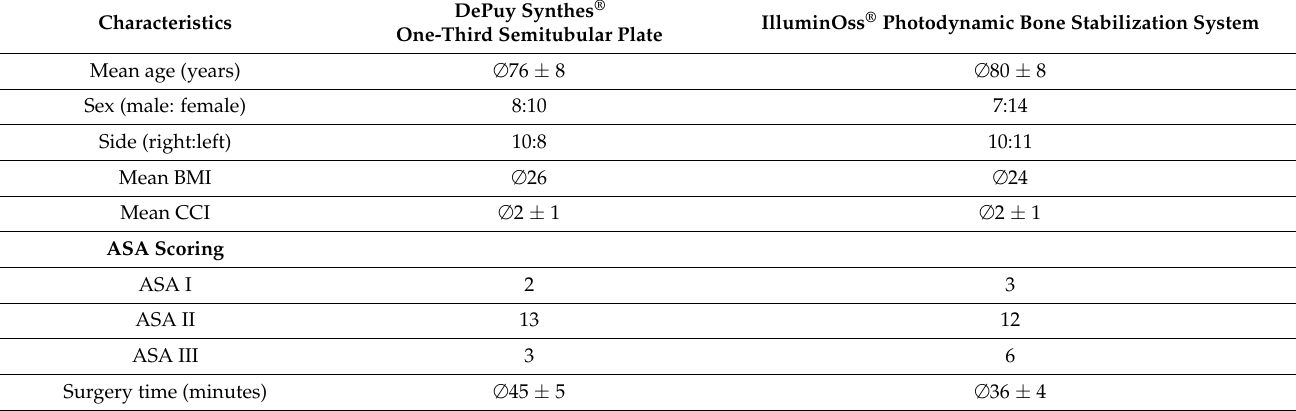
Table 2. Patient demographics and injury characteristics of both groups are shown. Data are provided as ∅ mean and +/ − standard